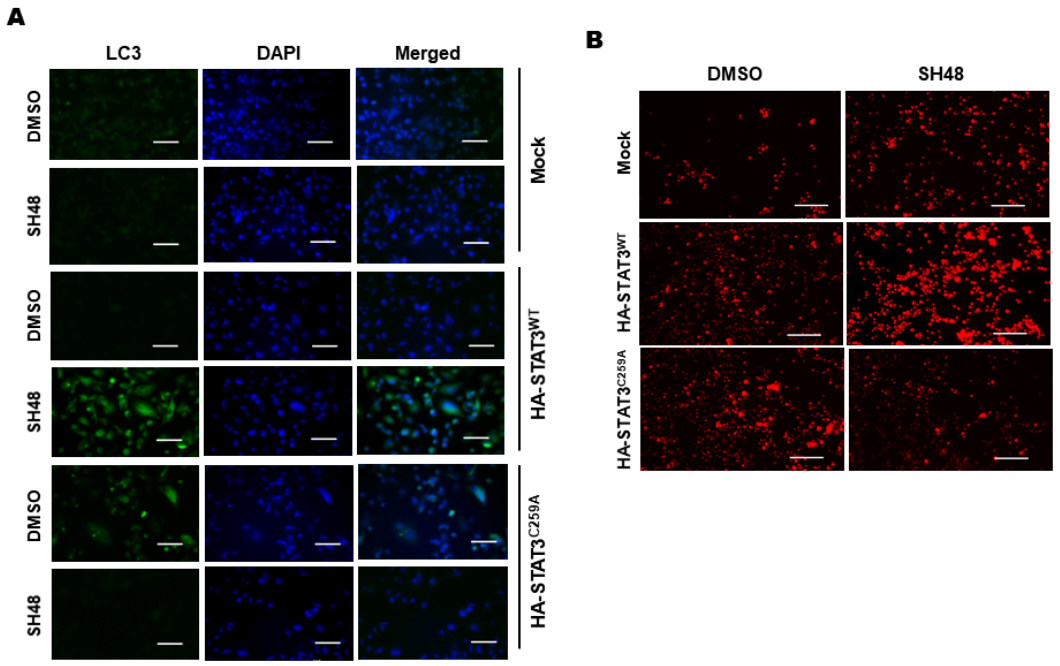
Figure 8. Role of cysteine 259 of STAT3 in SH48-induced autophagy. STAT3-null PC-3 cells were transfected with a mock vector or an expression vector for HA-STAT3 WT or mutant STAT3 C259A for 18 h. ( A ) The cells were treated with SH48 (10 µ M) for 24 h, The transfected cells were treated with DMSO or SH48 for 24 h, and then stained for LC3II ( A ) or lysotracker ( B ). Scale bar, 100 µ m.